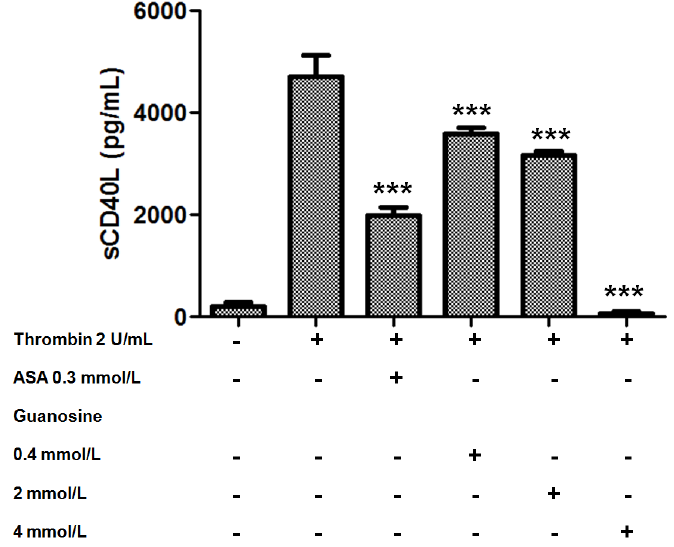
Figure 6. Effect of guanosine on release of sCD40L from human platelets induced by thrombin. Washed platelets were pretreated with saline, ASA, acetylsalicylic acid 0.3 mmol/L or guanosine (0.4 to 4 mmol/L) for 15 min at 37 °C and then stimulated by thrombin (2 U/mL). The graph depicts the mean ± SEM of n = 3 experiments. *** p < 0.001.